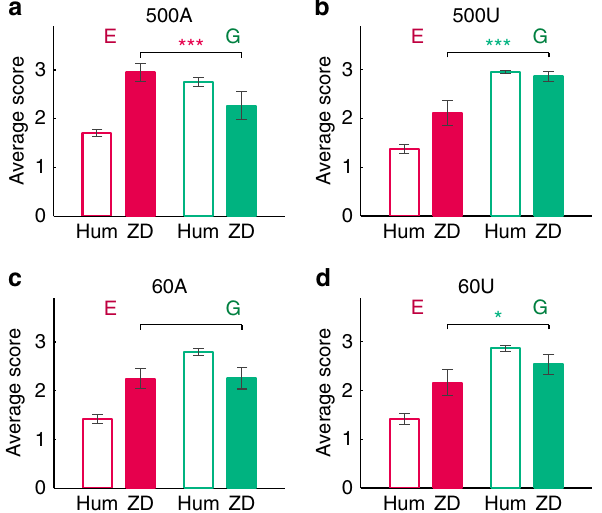
Figure 2 | Average scores for human subjects and the ZD strategies for all treatments. Each graph shows the average score earned by human subjects (unfilled bars) and ZD strategists (filled bars), for the extortionate (red) and generous (green) treatments, respectively. The scores for the extortionate strategy are significantly higher than the generous strategy in treatment 500A ( a ), but not in the other treatments ( b , c , d ). The scores of the generous strategy are higher than the extortionate strategy in both of the unawareness treatments ( b , d ). There is no significant difference in scores between extortionate strategy and generous strategy in the 60A treatment ( c ). Three stars indicate P o 0.001 (specifically, P ¼ 0.000 for the 500A treatment and P ¼ 0.000 for the 500U treatment), and one star indicates P o 0.05 (specifically, P ¼ 0.019 for the 60U treatment). The error bars indicate the 95% confidence interval. For details on average scores and statistical results, see Supplementary Tables 1 and 2, respectively. For individual level data, see Supplementary Tables 3 and 4.